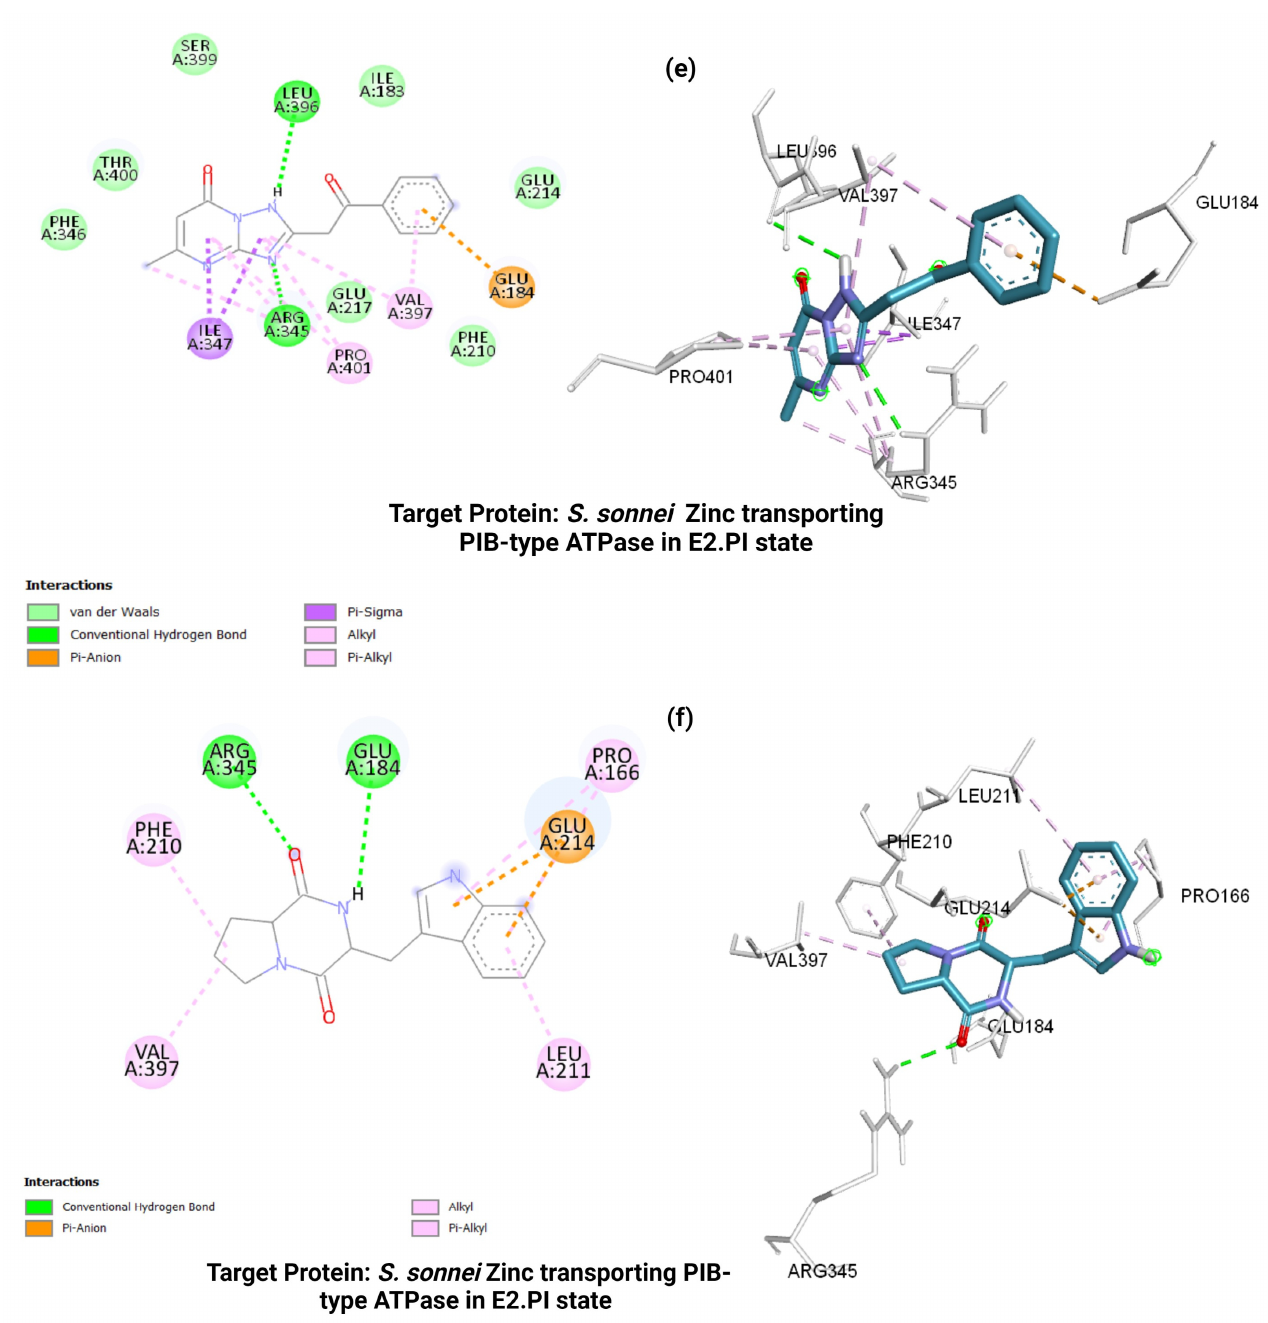
Figure 2. ( a , b ) represent binding interactions of essramycin and brevianamide F complexes with target protein S. aureus TyrRS, respectively; ( c , d ) represent binding interactions of essramycin and brevianamide F complexes with the target protein S. aureus dihydrofolate reductase; ( e , f ) represent binding interactions of essramycin and brevianamide F complexes with target protein S. sonnei Zinc-transporting PIB-type ATPase in E2.PI state.